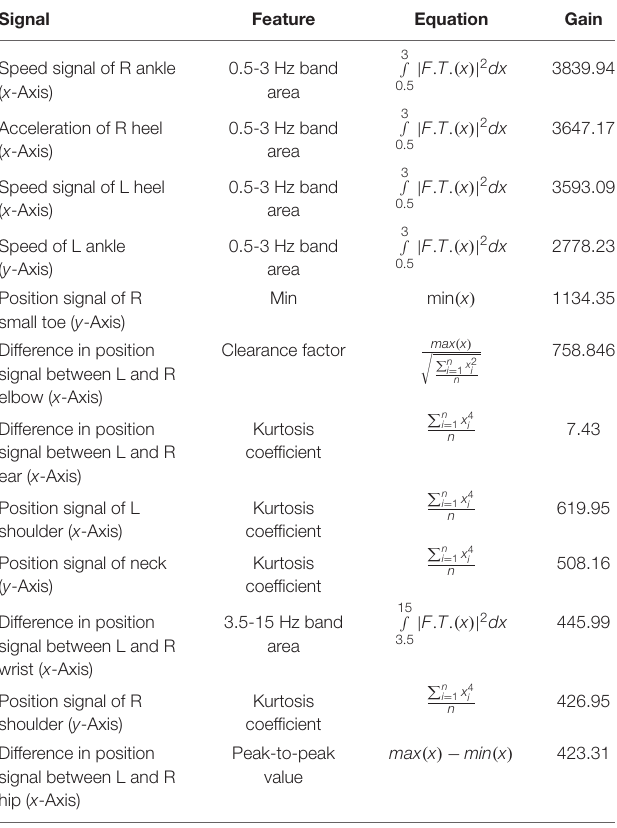
TABLE 5 | Feature importance for the turn-FOG recognition model based on the XGBoost gain (top 12).